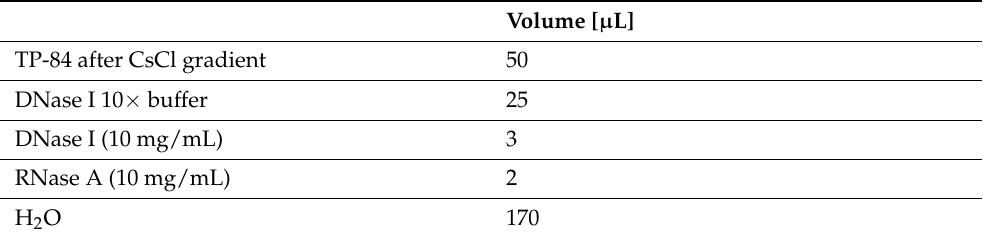
Table 3. Components of the bacteriophage reaction